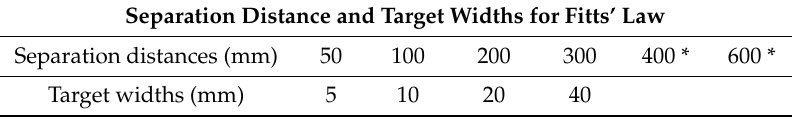
Figure 12. Experimental setup for Fitts’ Law tests. Targets (floating boxes) and visual cursor are shown where the user would perceive them to be though the display system. Target size and separation distance varied during the experiment, cursor size did not. The subject’s view point and the projection surface is shown in the top left illustration. Table 1. Separation distances and target widths used in the large reach Fitts’ Law experiment.